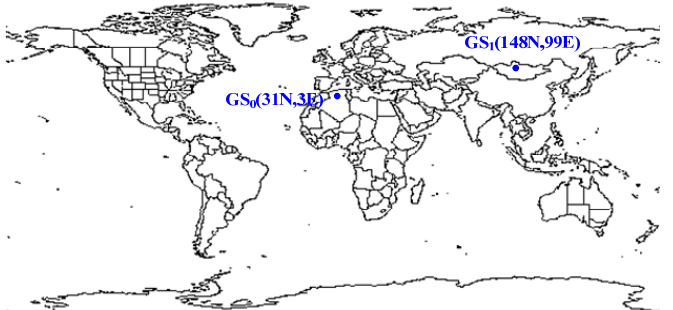
Figure 13. Location of the ground stations.